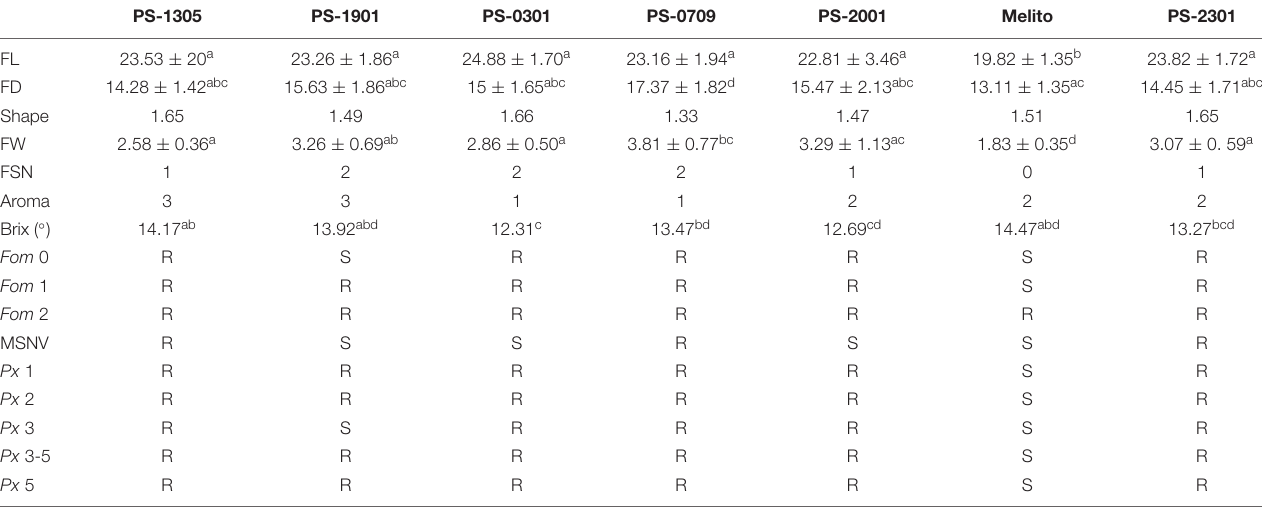
TABLE 1 | Fruit trait evaluation and pathogen resistance analysis of the seven genotypes of melon “Piel de Sapo.”